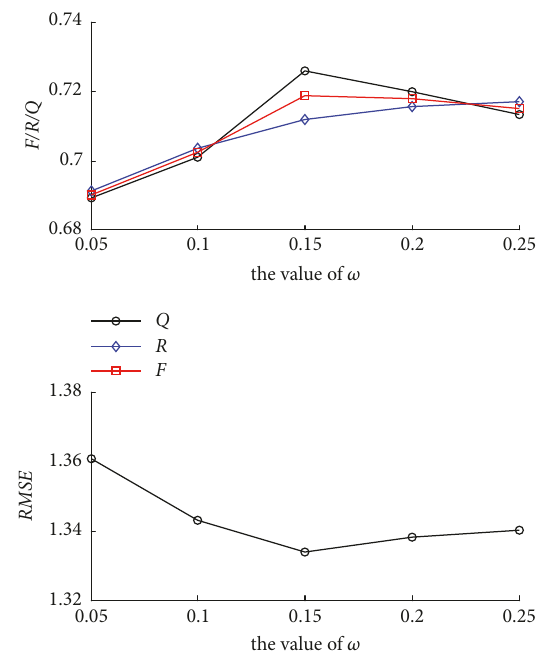
Figure 4: The comparison of the obtained results when 𝜔 is set to different